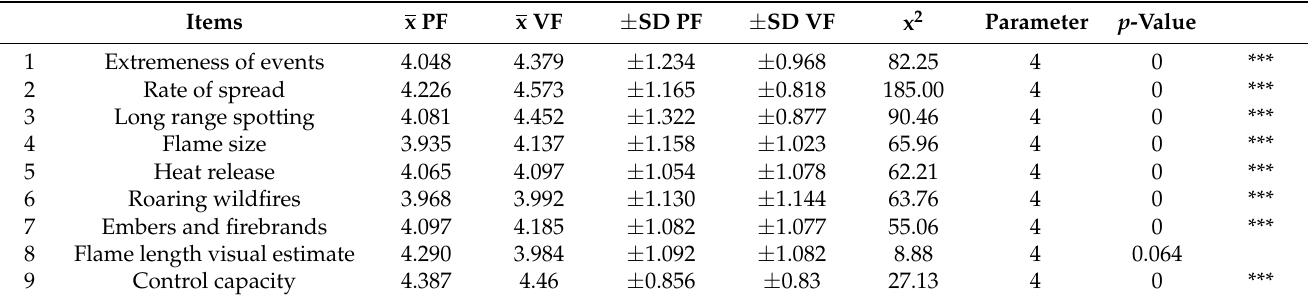
Topic 1 integrates three different sets of information: (i) classes of flame length (Table 3); (ii) list of fire characteristics that particularly impressed respondents (Table 4); (iii) and the